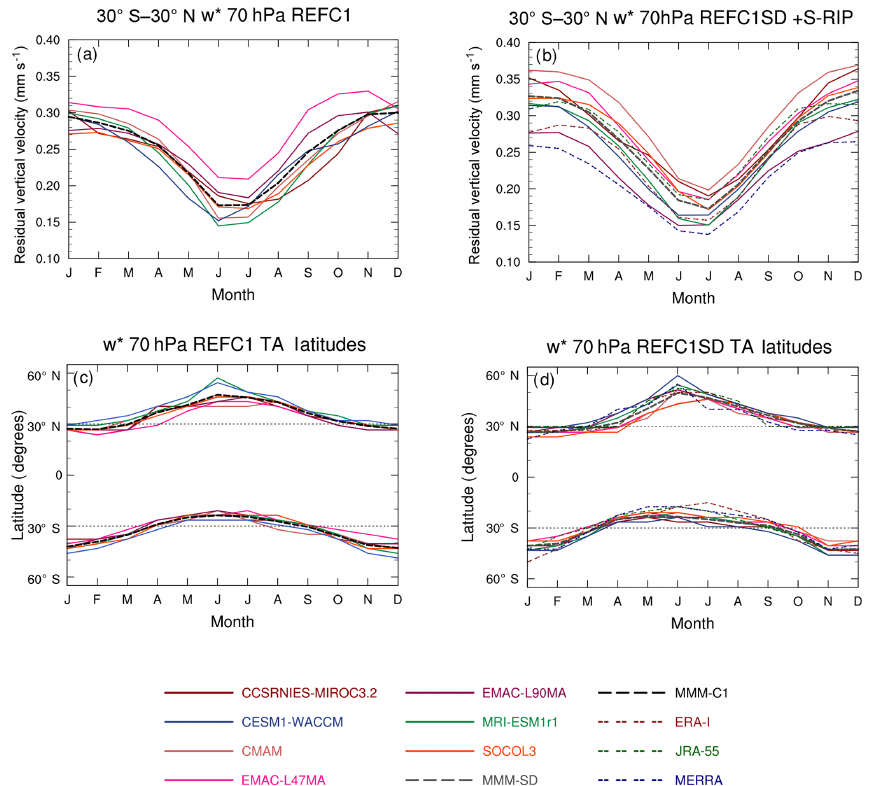
Figure 7. (a, b) Climatological annual cycle in w ∗ (mms − 1 ) at 70hPa between 30 ◦ S and 30 ◦ N in (a) REF-C1 and (b) REF-C1SD. (c, d) Climatological annual cycle in turnaround latitudes at 70hPa for each model in (c) REF-C1 and (d)